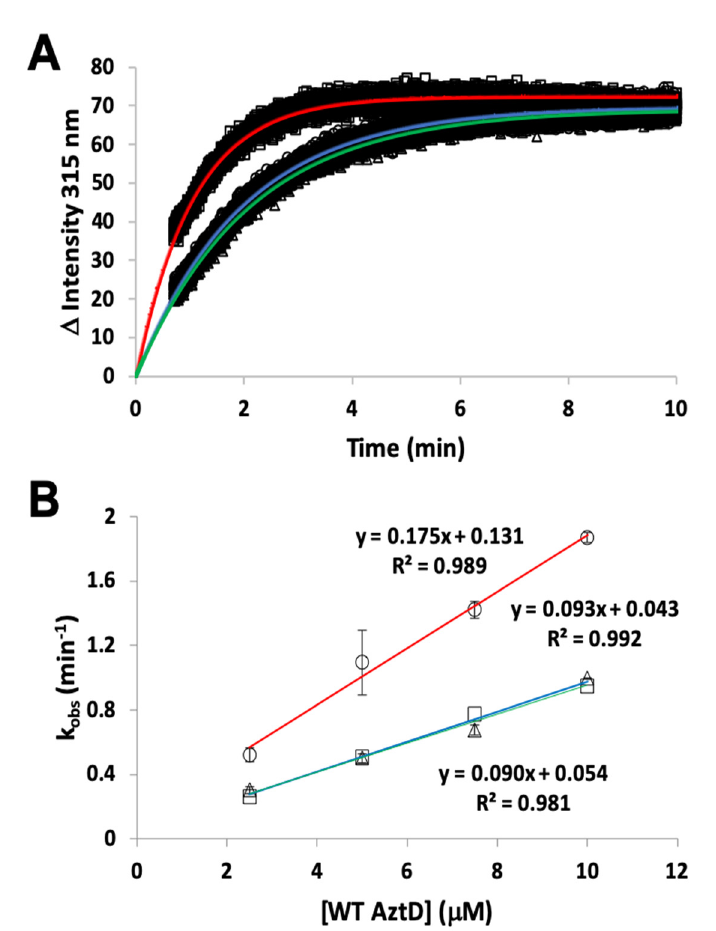
Figure 4. Kinetics of zinc transfer between mutants of AztD and AztC. ( A ) Representative kinetic data from standard fluorescence emission experiments for WT AztD to WT AztC (circles), ∆ NTM AztD to WT AztC (triangles), and WT AztD to ∆ Z-Loop (squares) with fits to a first order kinetic scheme (blue, green and red, respectively). ( B ) Observed first order rate constant versus AztD concentration for standard fluorescence data under pseudo-first order conditions. Error bars represent standard deviations from duplicate experiments (n = 2) except for the WT AztD to WT AztC experiment, which was run a single time to confirm previous data under current conditions. Symbols and linear fit colors are as for ( A ).